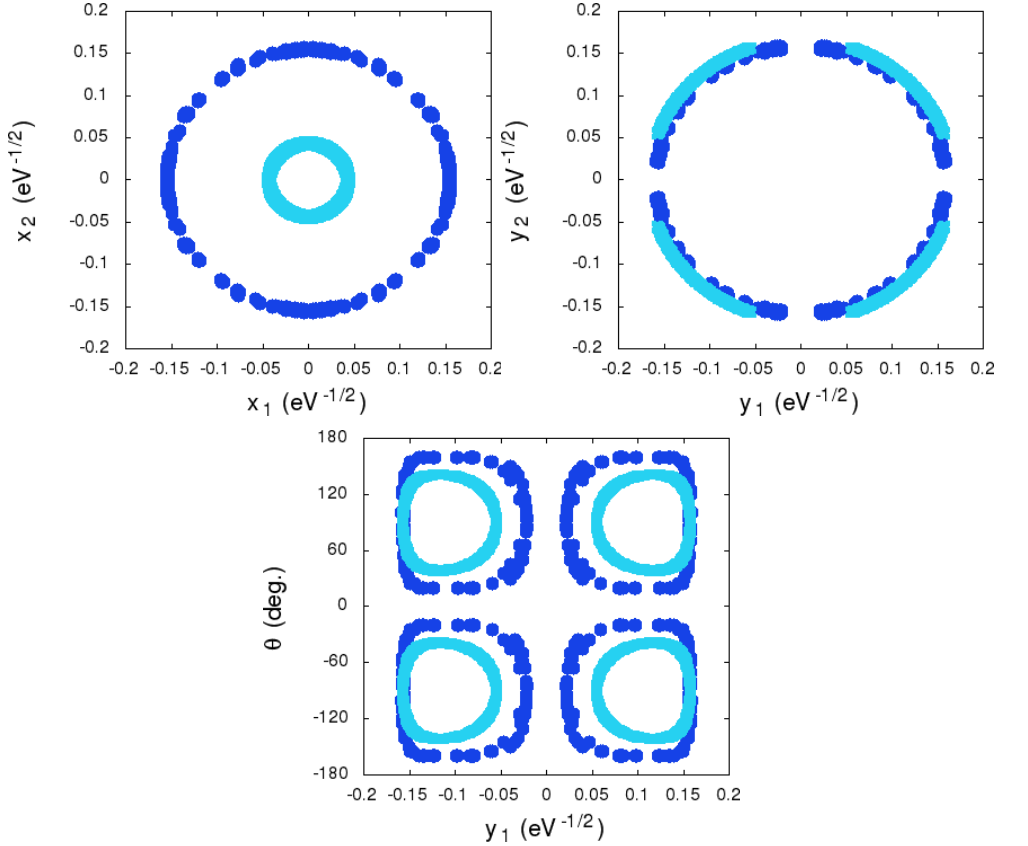
Figure 1 . Rescaled parameter space for both the mass orderings. The plots in sky blue (deep blue) color represents the parameter space for normal (inverted) mass